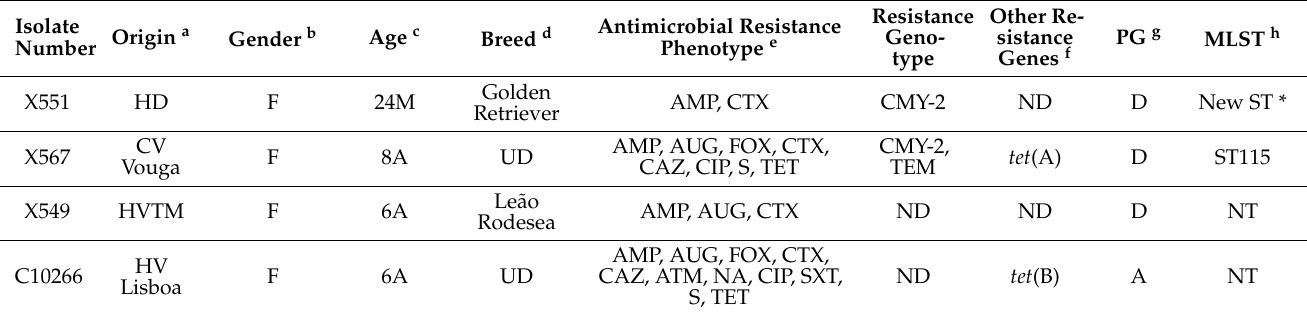
Table 2. Phenotypic and molecular features of ESBL-negative E. coli isolates recovered from healthy and sick dogs in Portugal. Isolate Origin a Number